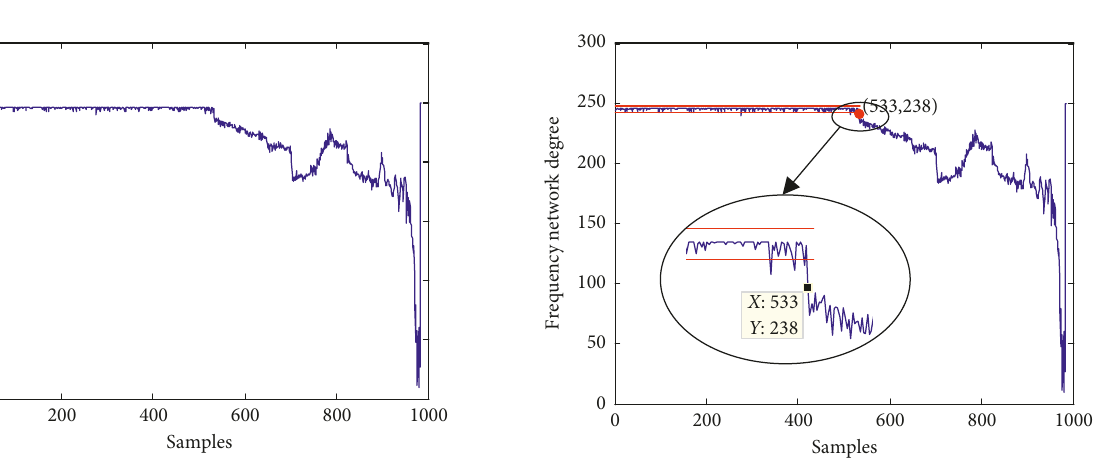
Figure 13: The average degree of bearing all life. Figure 14: Bearing performance degradation alarm